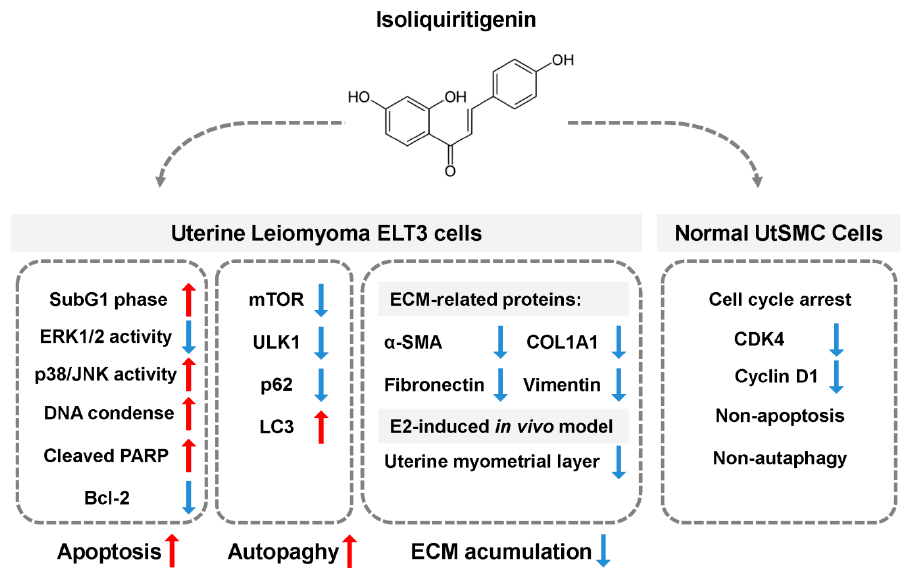
Figure 9. Schematic representation of the inhibitory effect of ISL on the proliferation of uterine leiomyoma through promoting the cell death program. Treatment of uterine leiomyoma ELT3 cells with ISL induced apoptosis and activated autophagy cell death through regulation of MAPK pathway. The expression of extracellular matrix (ECM)-associated proteins was decreased after ISL treatment in both in vitro and in vivo models. In addition, ISL treatment suppressed primary human uterine smooth muscle UtSMC cells growth via arresting the cell cycle.